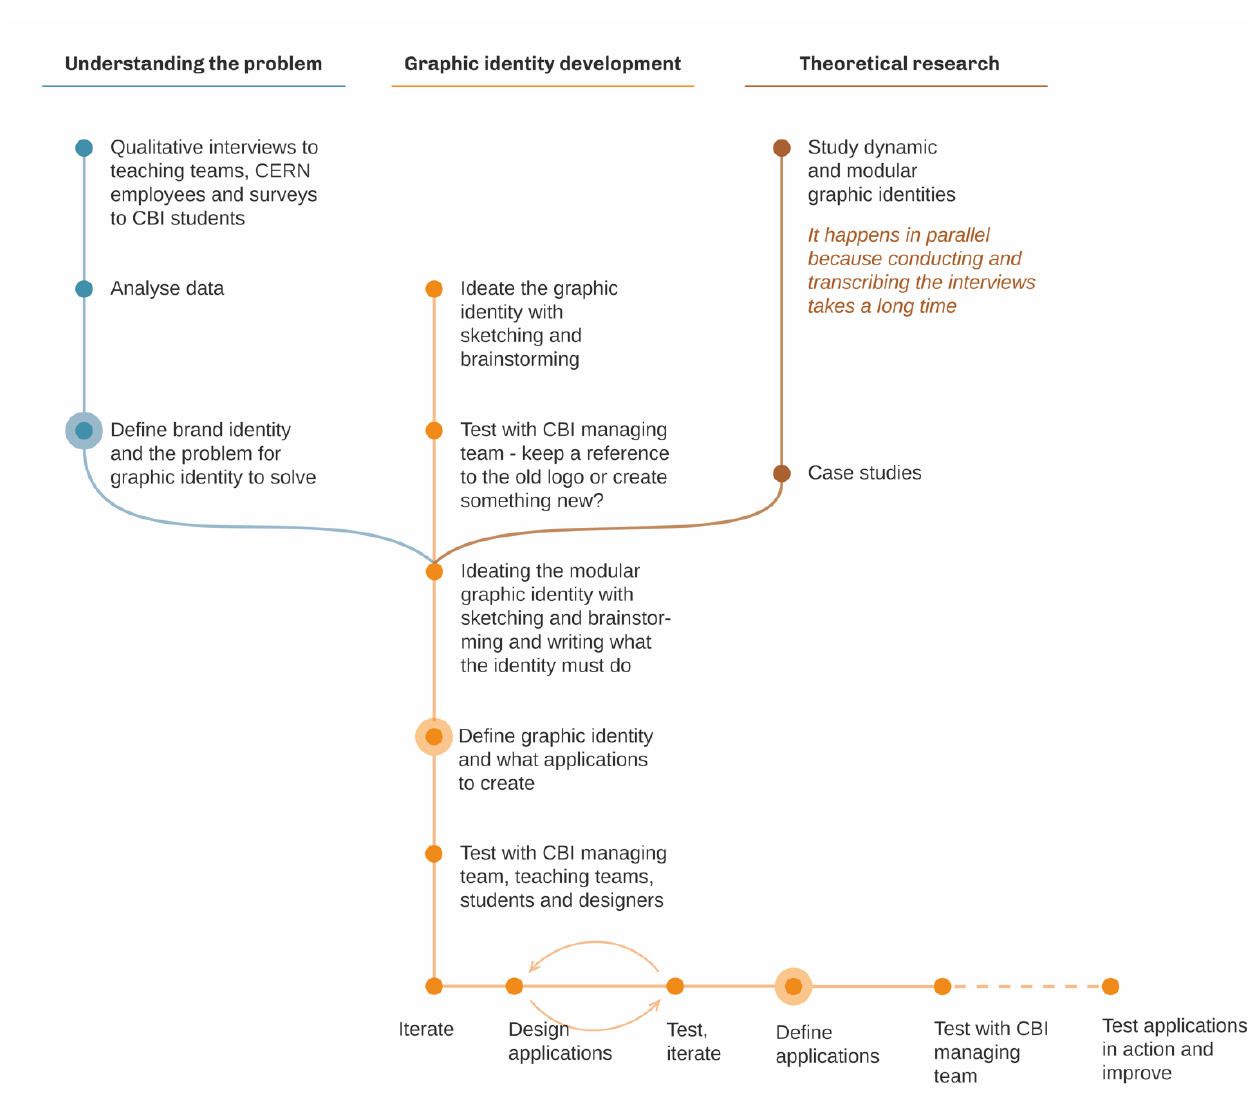
Fig. 5. Project development